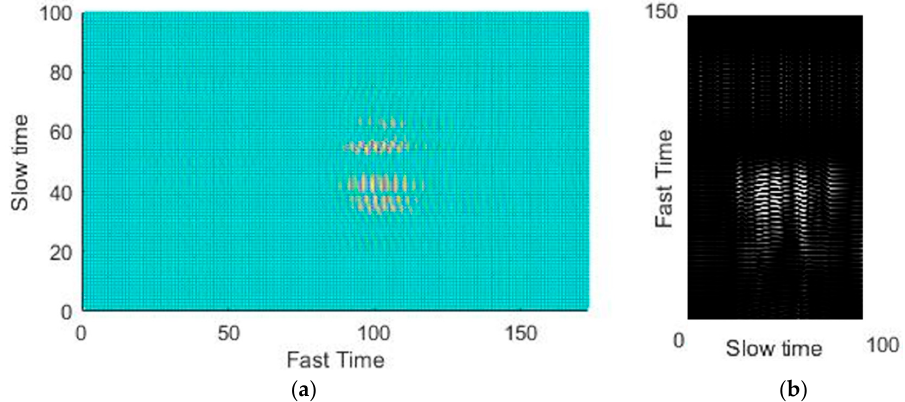
Figure 6. Image data corresponding to single gesture: ( a ) 2D data matrix and ( b ) corresponding greyscale image. Algorithm 1. Transformation of radar signals into images